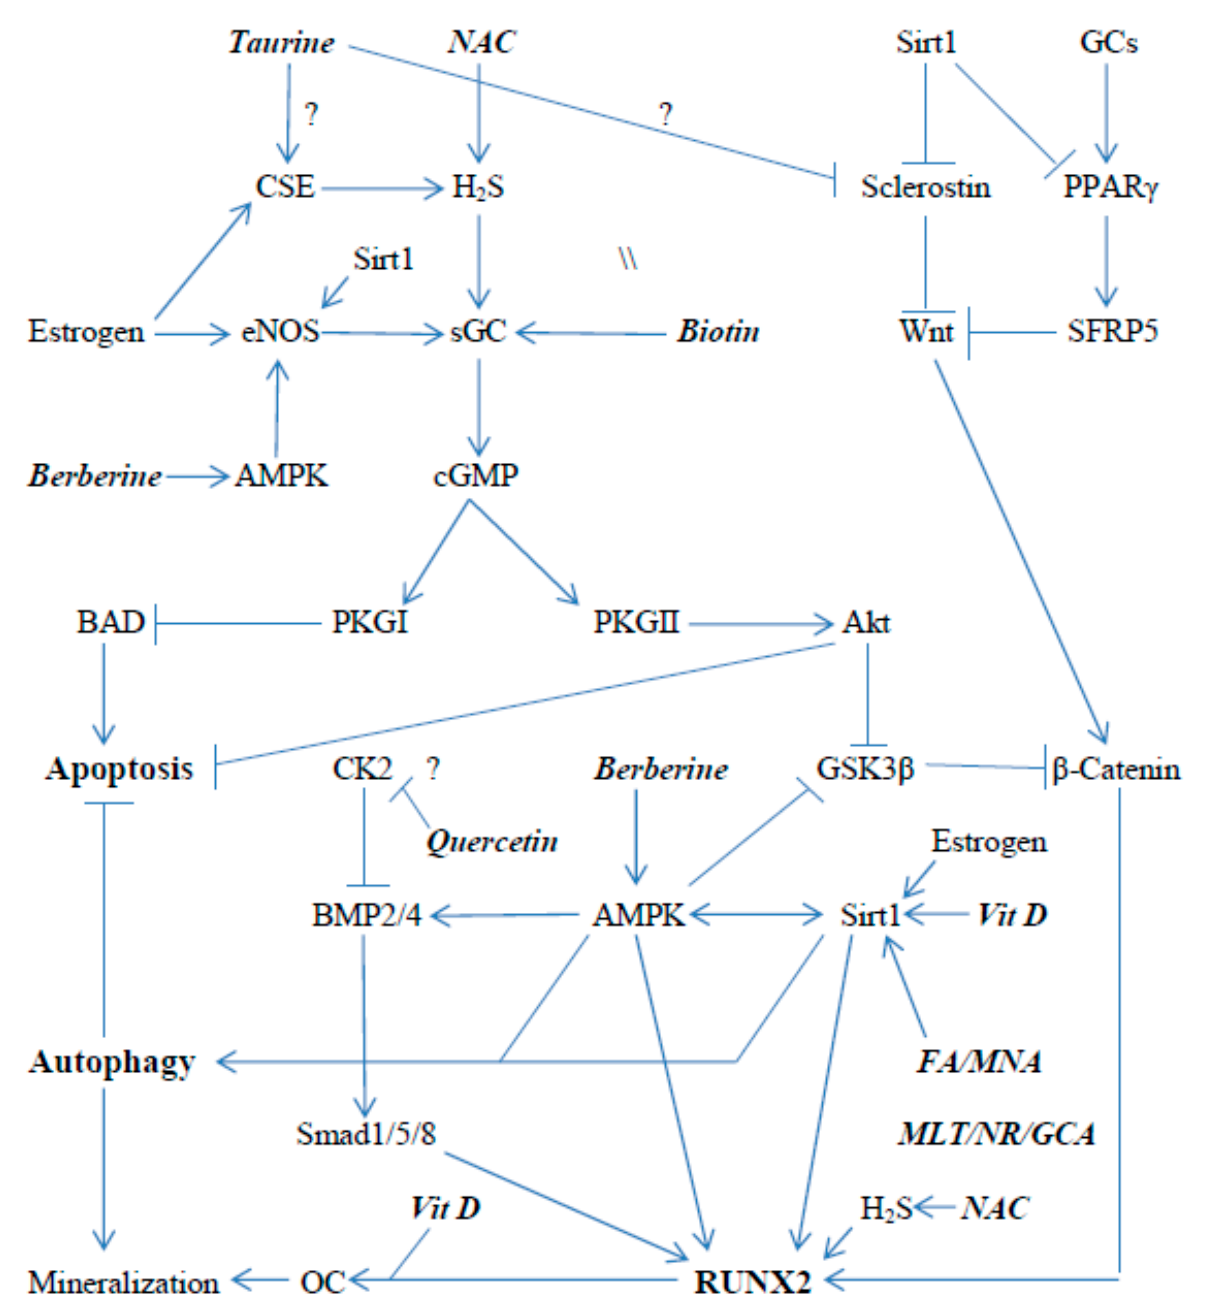
Figure 1. Nutraceutical mechanisms for the support of RUNX2 activity, promotion of autophagy, and inhibition of apoptosis in osteoblasts/osteocytes. NAC = N-acetylcysteine; FA = ferulic acid; MNA = N1-methylnicotinamide; MLT = melatonin; NR = nicotinamide riboside; and GCA = glucosamine.